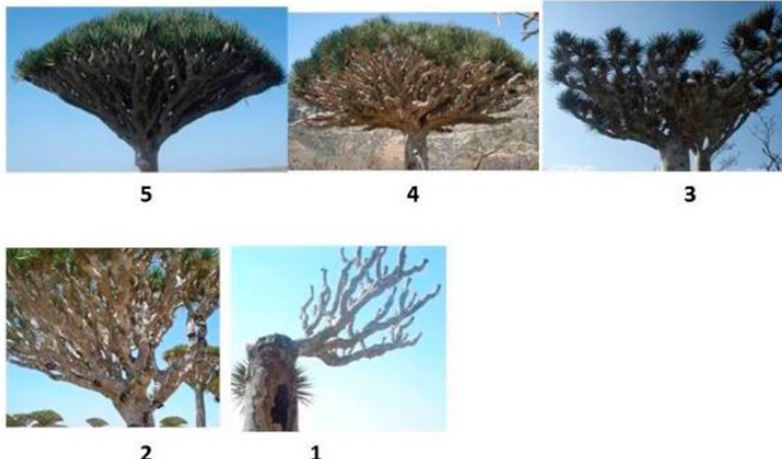
Figure 4. Crown status categories (own classification). ( 5 ): full crown without any broken branches and with very few small wounds; ( 4 ): full crown with some broken branches and wounds; ( 3 ): damaged crown with many broken branches and wounds; ( 2 ): highly damaged crown with nearly half of the crown affected by many wounds and broken branches and branches with very few leaves; ( 1 ): crown with few branches and dead branches but the tree is still alive. Table 2. The interviews covered di ff erent groups of harvesters (in 3 di ff erent